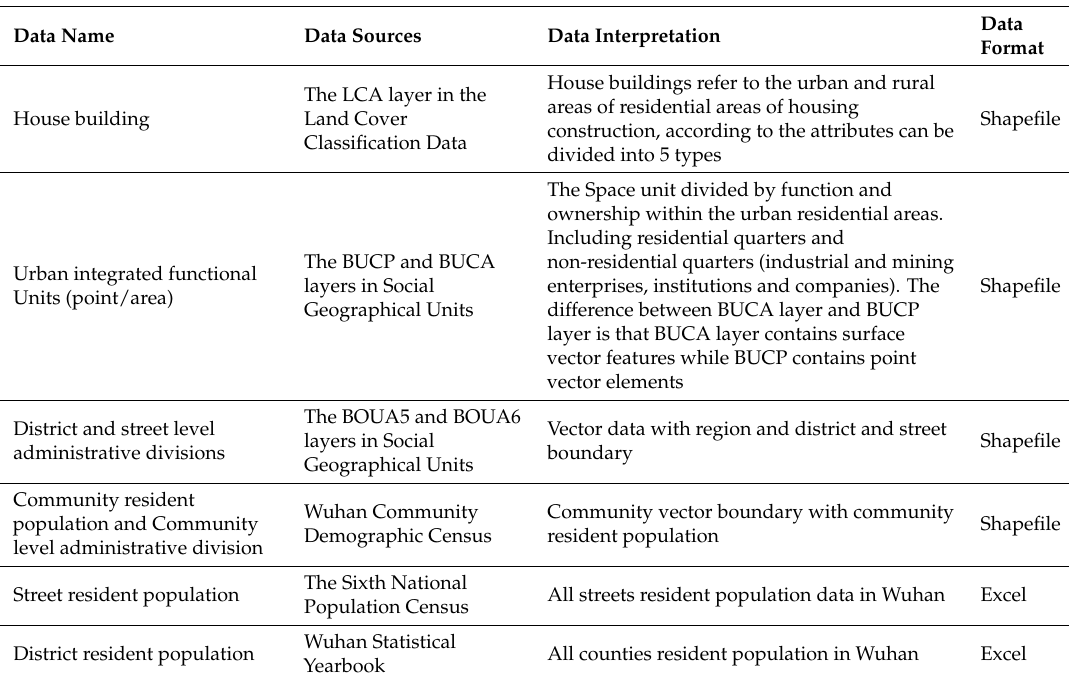
Table 1. Detailed data usage